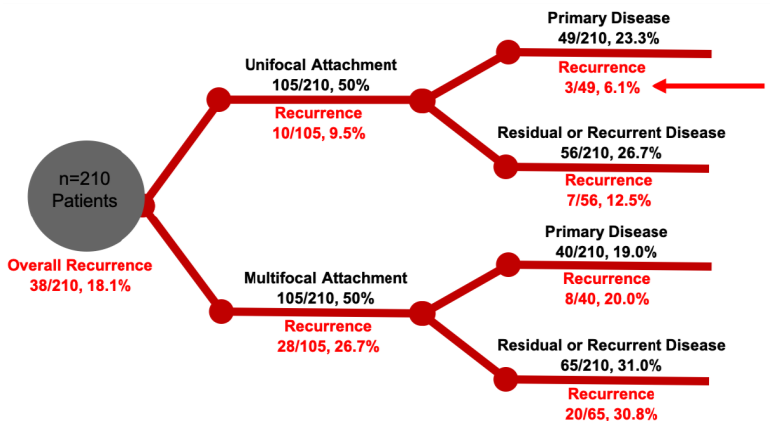
Figure 8. IP outcomes stratified by attachment (unifocal vs. multifocal), primary or residual/recurrent disease by a single institution. Red arrow denotes optimal outcome after management of unifocal primary disease.